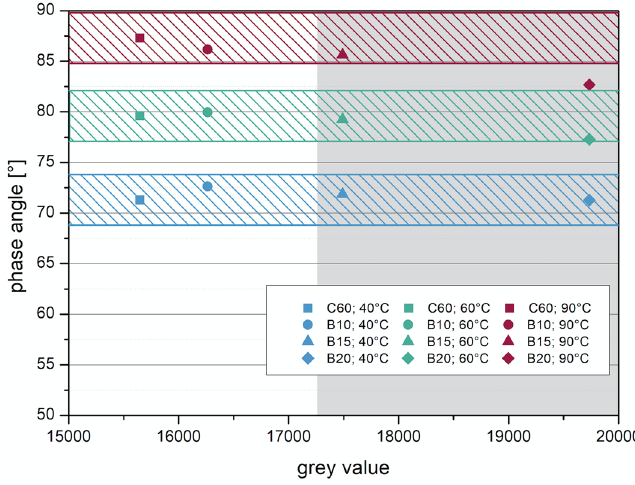
Figure 17. Correlation between phase angle and gray value—barite powder.